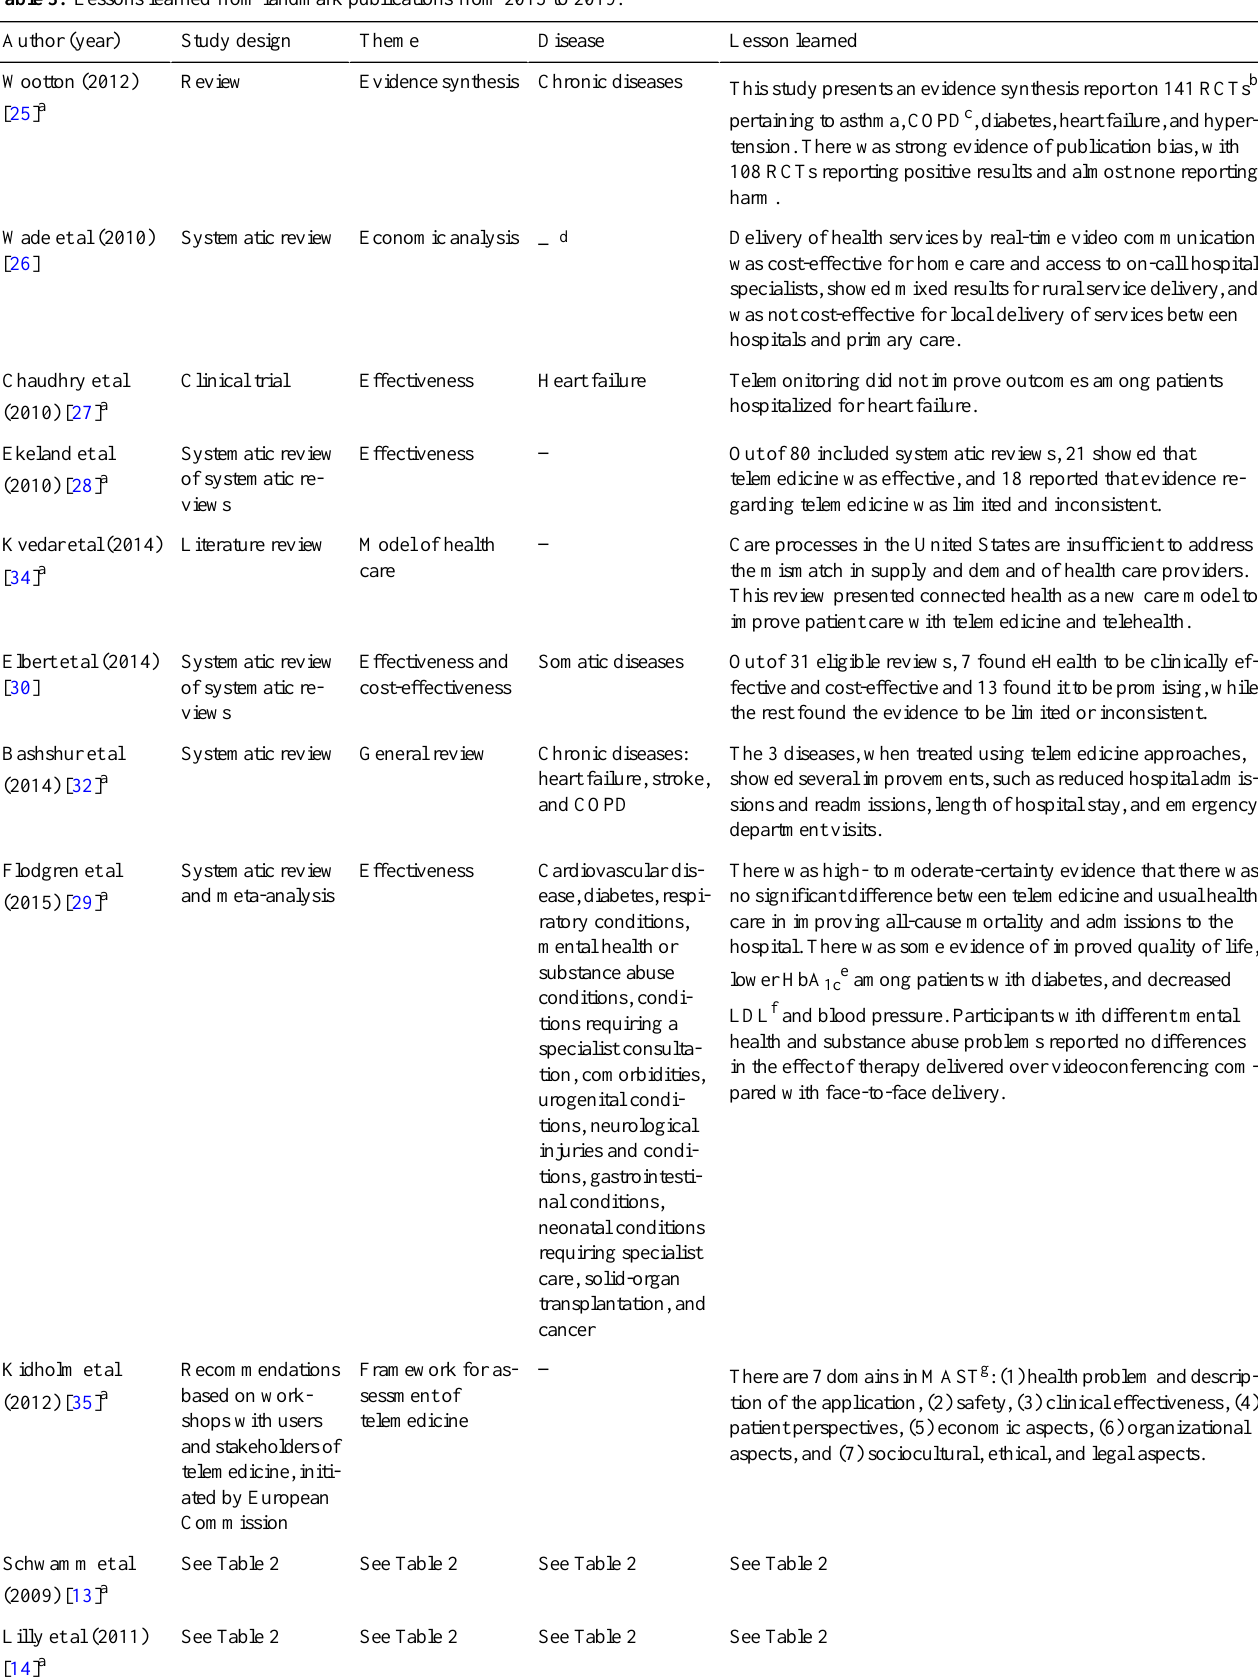
Table 3. Lessons learned from landmark publications from 2015 to 2019.